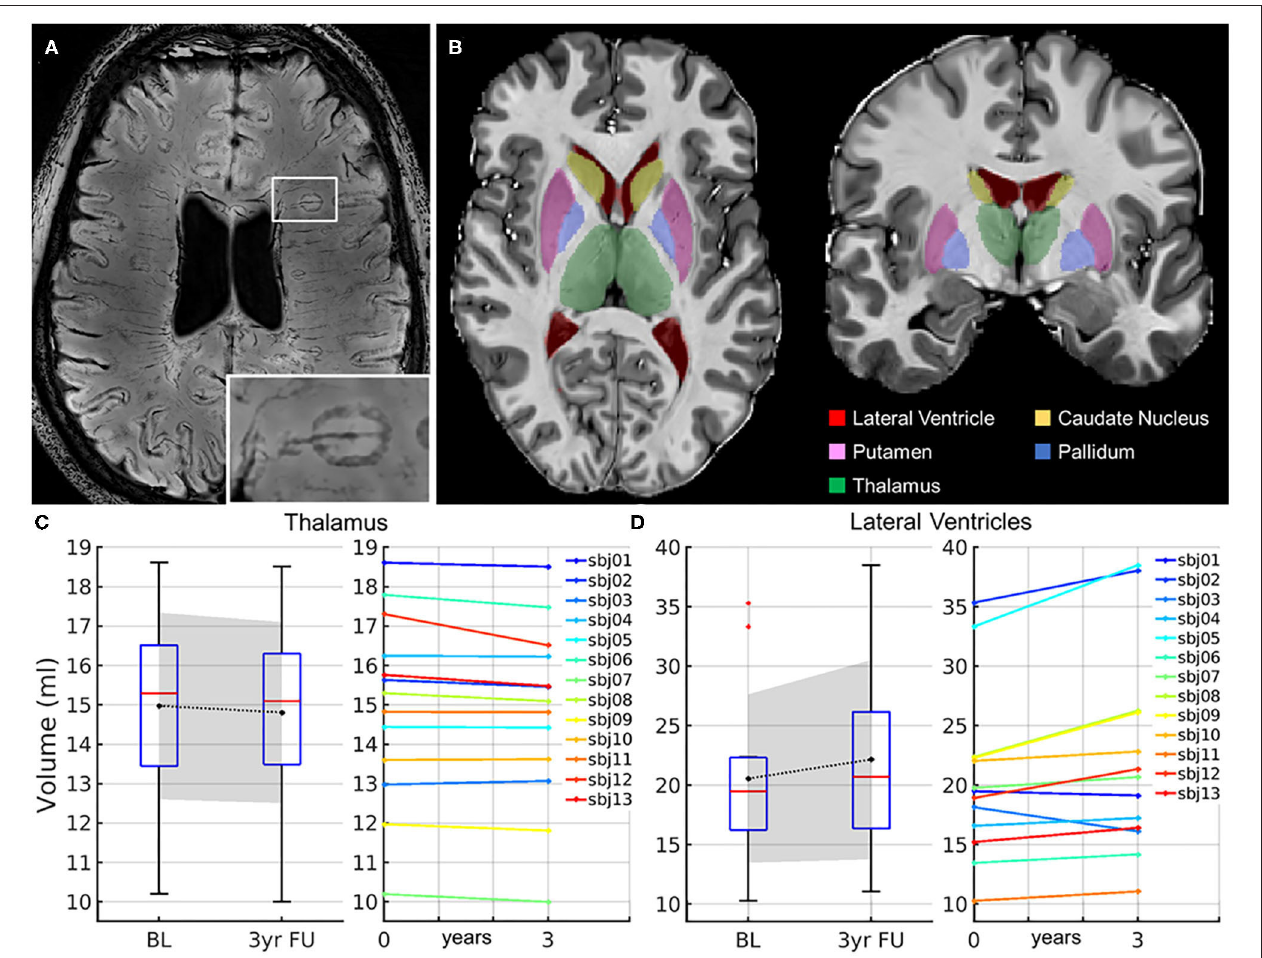
FIGURE 1 | Images scanned at 7T. (A) FLAIR-SWI overview image shows multiple hyperintense white matter lesions surrounded by SWI-detected hypointense iron rims in a 27-year-old male relapsing-remitting multiple sclerosis (RRMS) patient with 7 years of disease duration and a Multiple Sclerosis Severity Score (MSSS) of 6.98. The white rectangle indicates the magnified iron rim lesion (IRL). (B) Segmentation of the subcortical deep gray matter structures. Subcortical segmentation maps are overlaid on the 7T T1-weighted MP2RAGE single-subject template from a male RRMS patient. (C) Significant reduction of the thalamus volume within 3 years within the cohort (left) and according to individual courses (right). (D) Significant enlargement of the lateral ventricles of the cohort (left) and according to individual courses (right). BL, baseline; FU, follow-up; ml, milliliter; sbj, subject; yr,